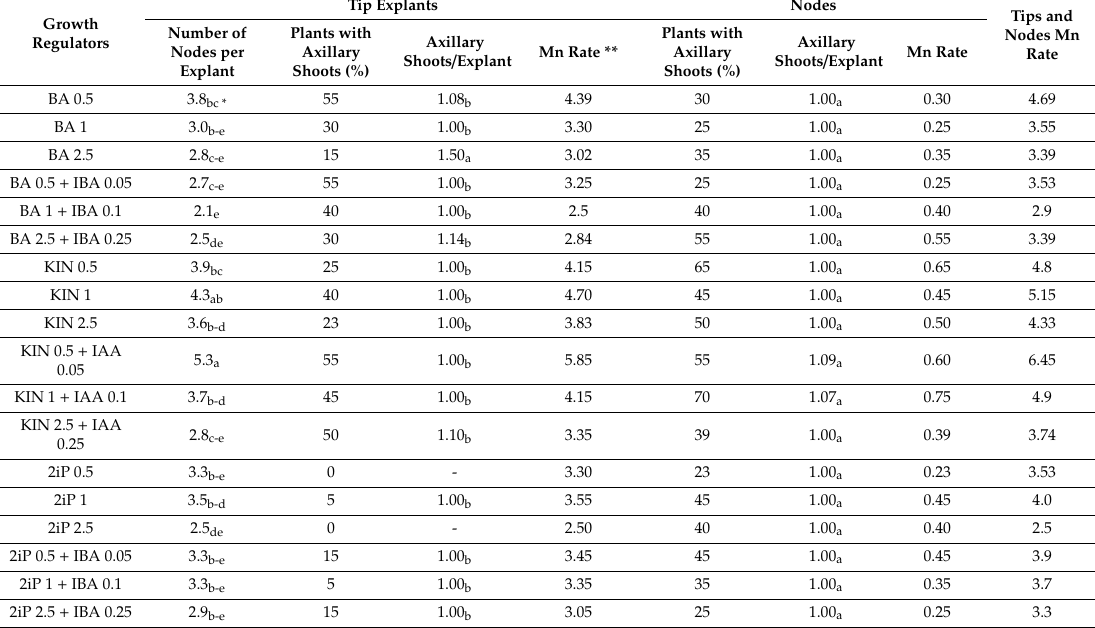
Table 3. Regeneration and multiplication of S. lapponum shoots in tissue culture depending on the growth regulators added to the